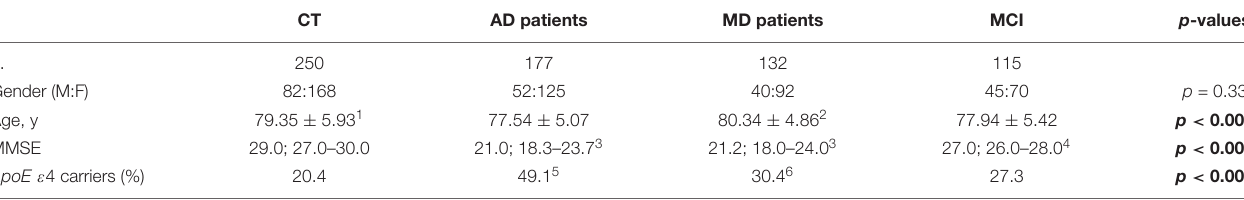
TABLE 1 | Demographic and clinical characteristics of the cohort. CT AD patients MD patients MCI p -values